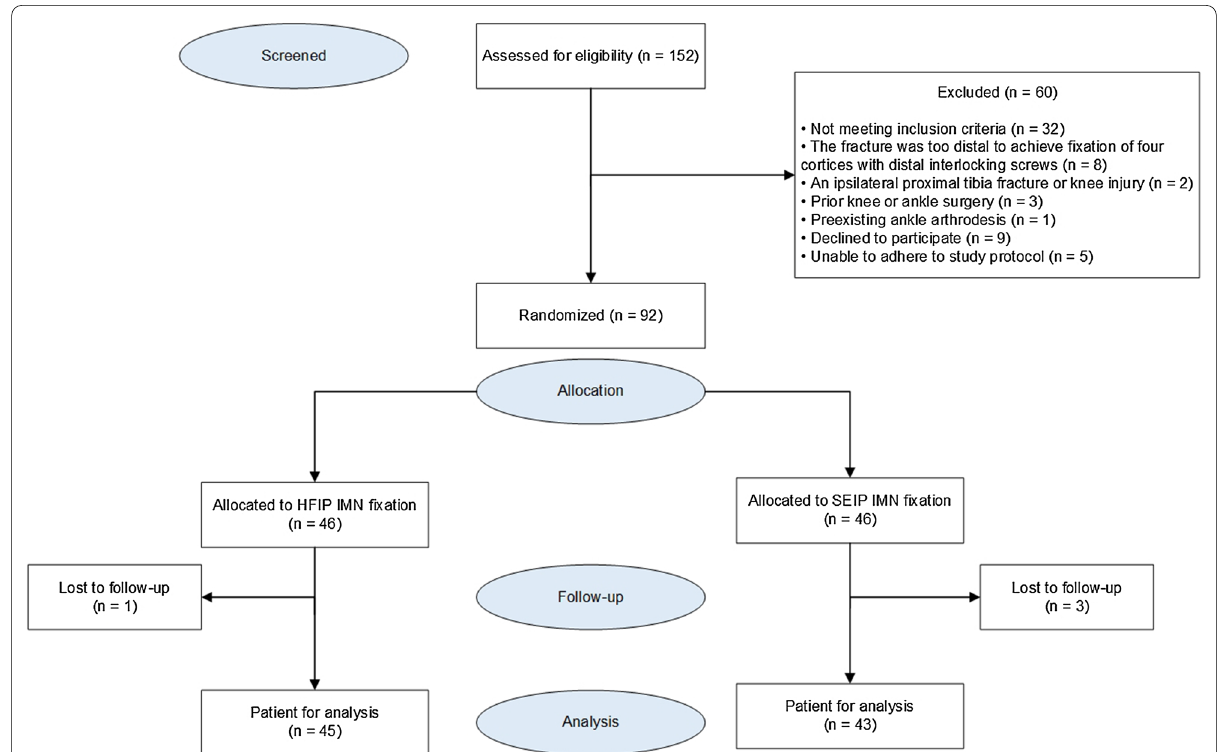
Fig. 6 A flow diagram. SEIP semi‑extended infrapatellar, HFIP hyperflexed infrapatellar, IMN intramedullary nail